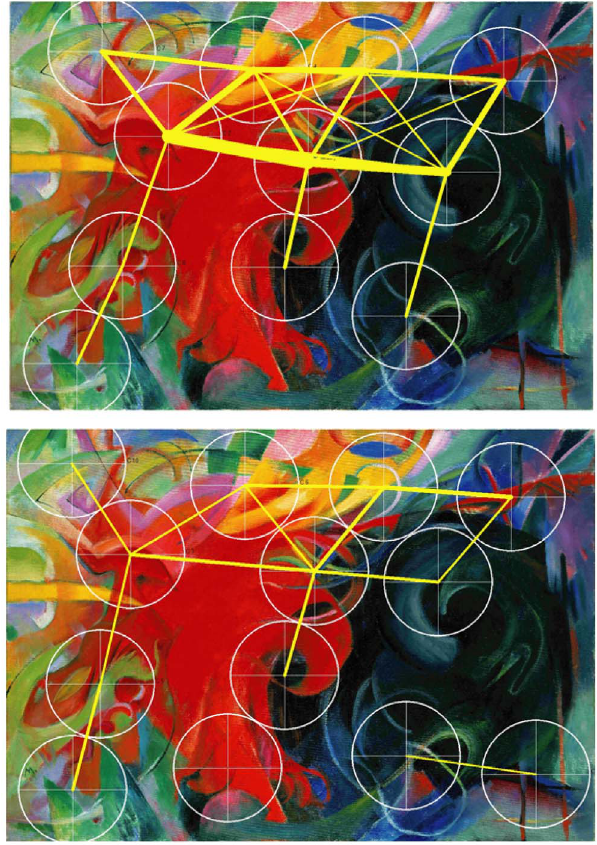
Fig. 8. Speaking effects on frequently repeated transitions between fixation clusters – Marc. Upper part: Frequently repeated transitions between fixation clusters of the experimental group during minute 11 to 15. Cluster size: 120 mm. Lower part: Frequently repeated transitions between fixation clusters of the control group during minute 11 to 15. Cluster size: 120 mm.